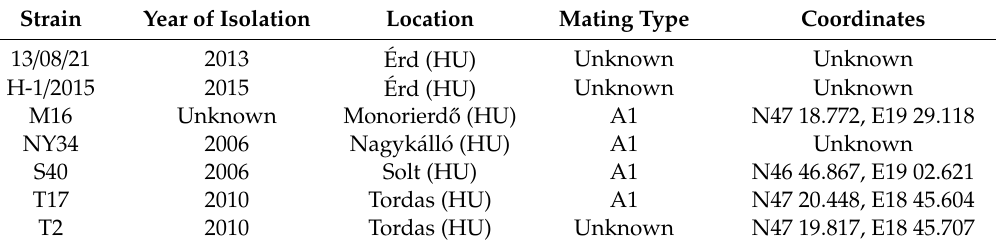
Table 1. Data of the Phytophthora infestans isolates used in this